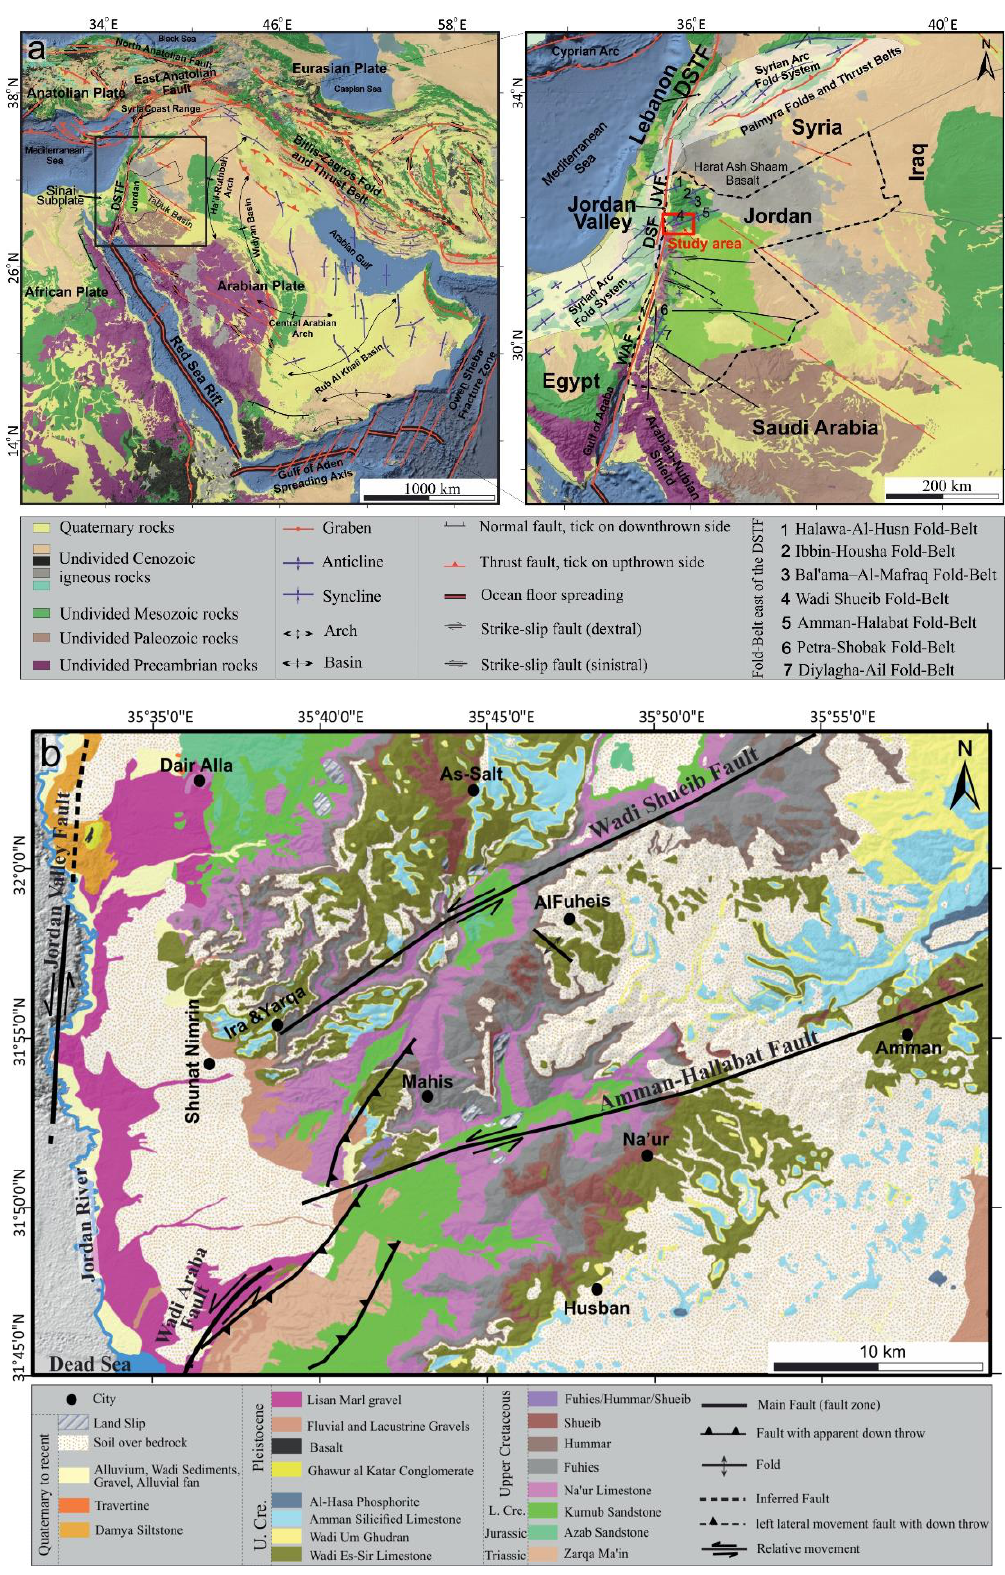
Figure 1. ( a ) A generalized map of geological units (based on [35,36]) and the main tectonic elements of the Middle East region compiled from [37–46]. The location of the fold-belts east of the Dead Sea Transform is based on Atallah [47,48], and that west of it is based on Chaimov et al. [49]. DSF: Dead Sea Fault; JVF: Jordan Valley Fault; WAF: Wadi Araba Fault. ( b ) Detailed geological map of the study area (modified from [50–53]).